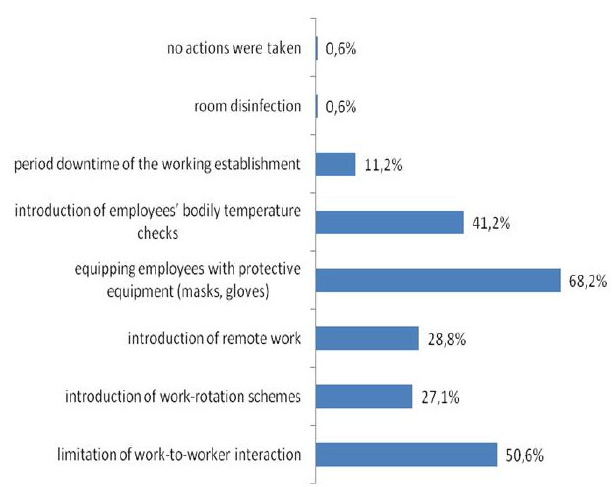
Figure 2. Activities strengthening work security imple- mented in the enterprises in relation to the Covid-19 pan- demic*. *Respondents could select more than one answer.